Question: Give a one-sentence summary of this figure.
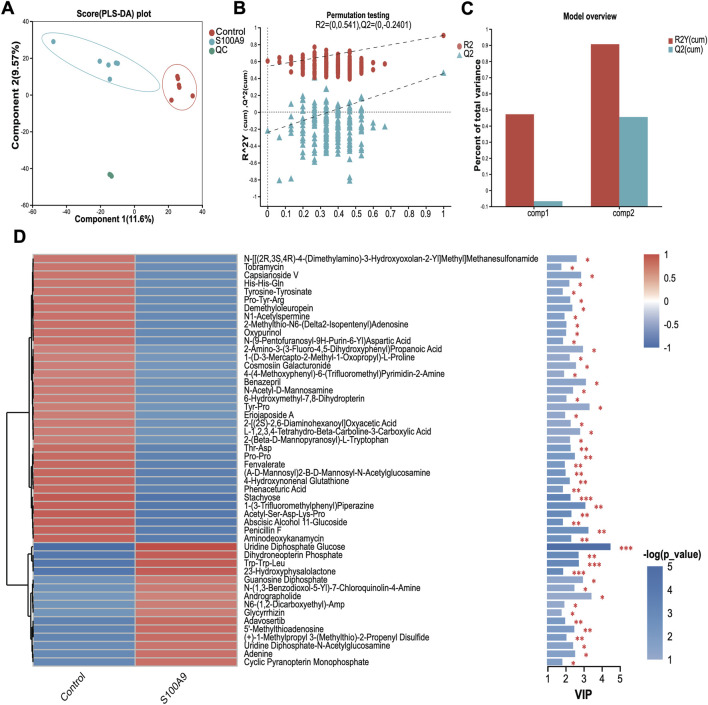
Answer: Metabolic alterations in C2C12 cells following rS100A9 treatment. (A) PLS-DA score plot showing distinct separation between S100A9 and Control groups. (B) Permutation test validating the model robustness (Q2intercept < 0). (C) Summary of model fit (R2Y) and predictive ability (Q2). (D) Heatmap of top differential metabolites and corresponding VIP scores.